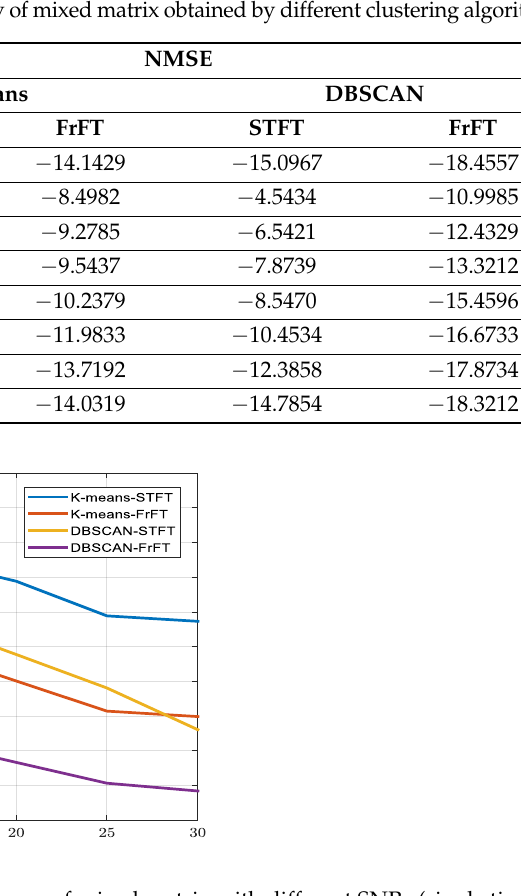
Figure 12. Comparison of estimation accuracy of mixed matrix with different SNRs (single time).